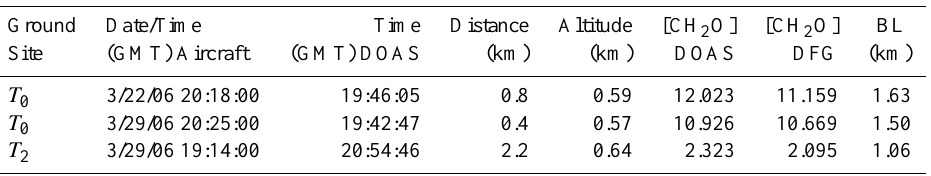
Table A2b. C-130 (DFG) and ground-based DOAS comparisons of ambient CH 2 O over Mexico City. The distance is the aircraft distance to the site and the altitude is the height above ground from the aircraft radar. The mixing ratios are in ppbv. The assumed boundary layer height (BL) in km is also indicated as well as the DOAS measurement time. The DOAS CH 2 O was normalized by the DOAS/C-130 measurements of NO 2 to account for errors in the BL determination.